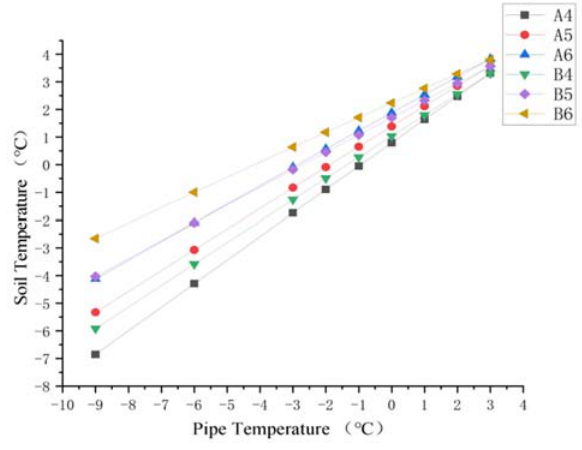
Figure 15. Diagram of soil temperature trend for pipes beneath cross-section A and B.